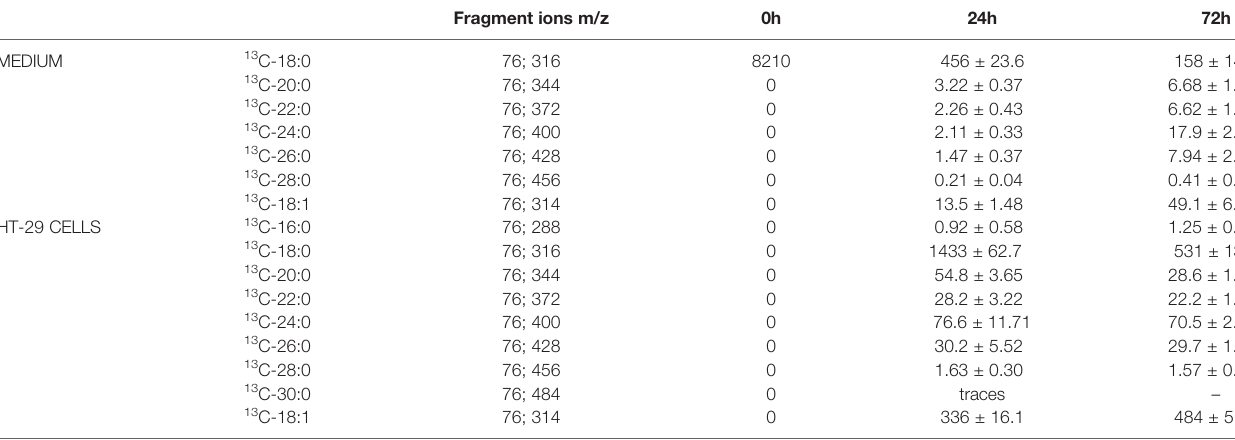
Values are mean ± SEM.